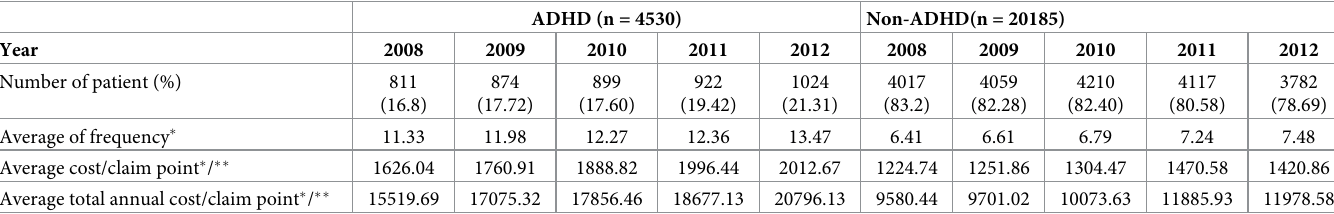
Table 2. Use of rehabilitation resources by 3–12-year-old children from the National Health Insurance Research Database. ADHD (n =